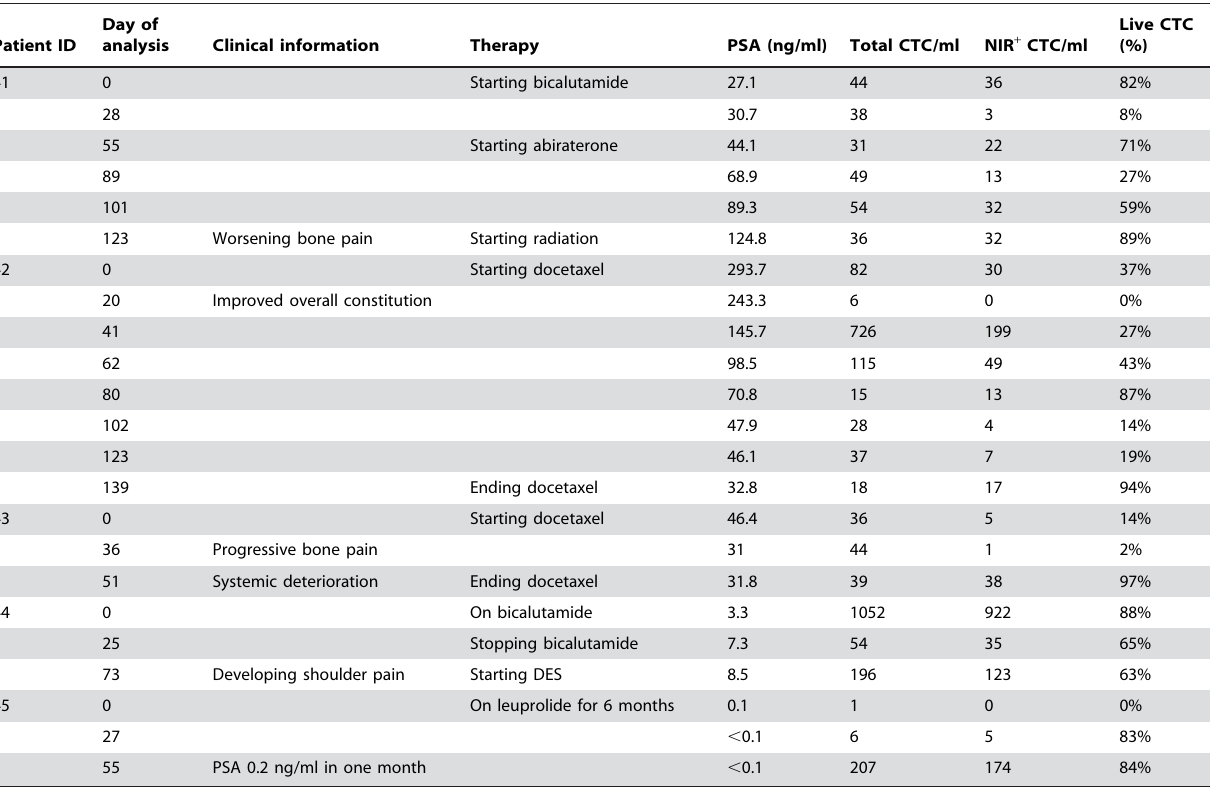
Table 2. Summary of metastatic prostate cancer